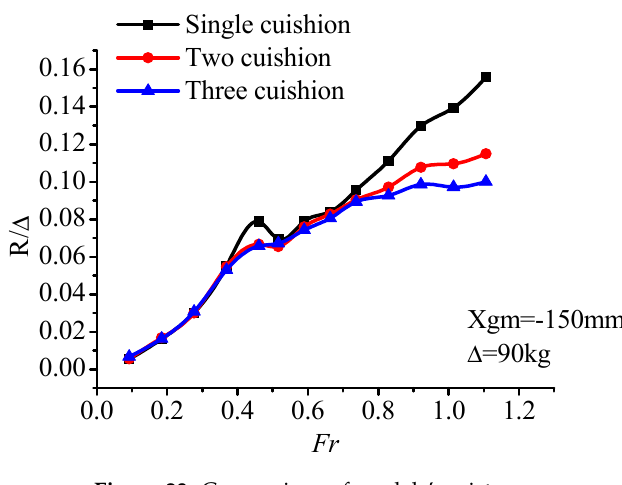
Figure 23. Comparison of models’ resistance .